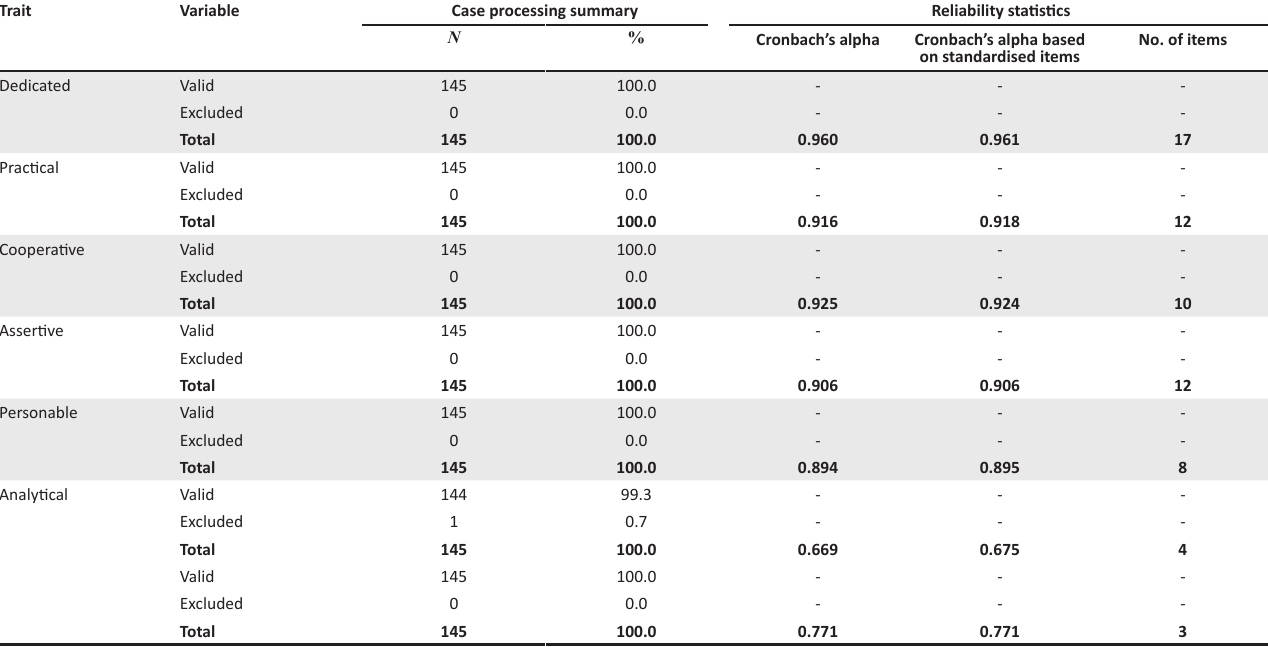
TABLE 6: Reliability statistics for the Leader Trait